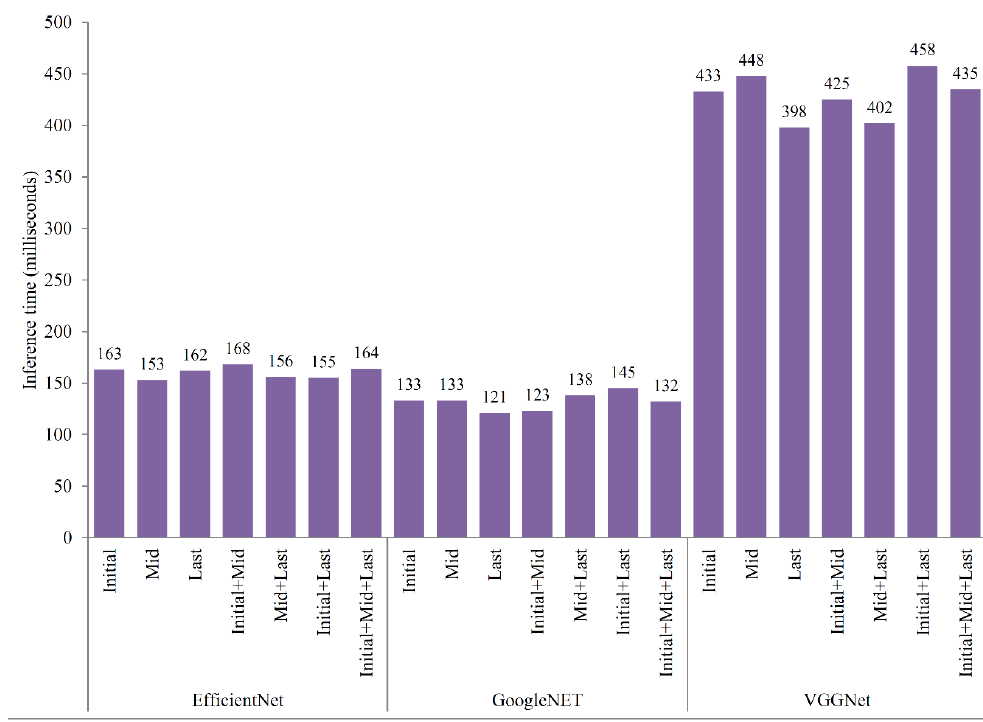
Figure 7. Inference time comparison for combinations of various convolutional neural networks.